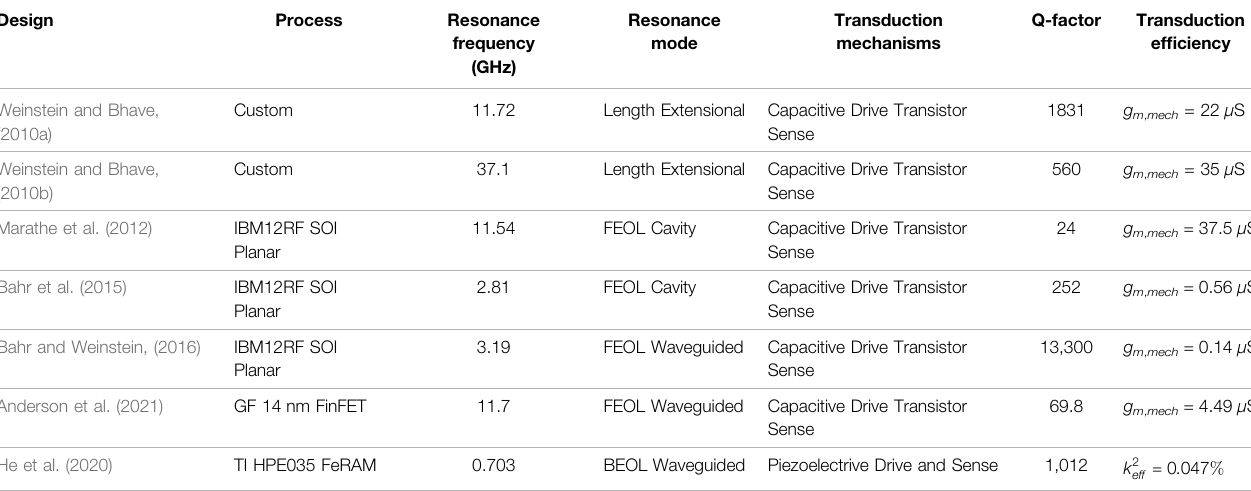
TABLE 1 | Comparison of CMOS-MEMS designs implemented in different process technologies.